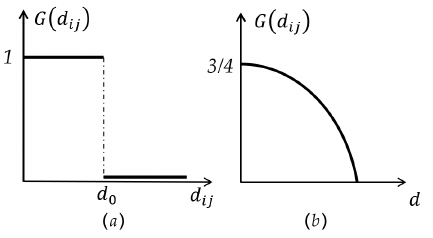
Figure 5. Attenuation function of 2SFCA ( a ) and kernel density 2SFCA ( b ).